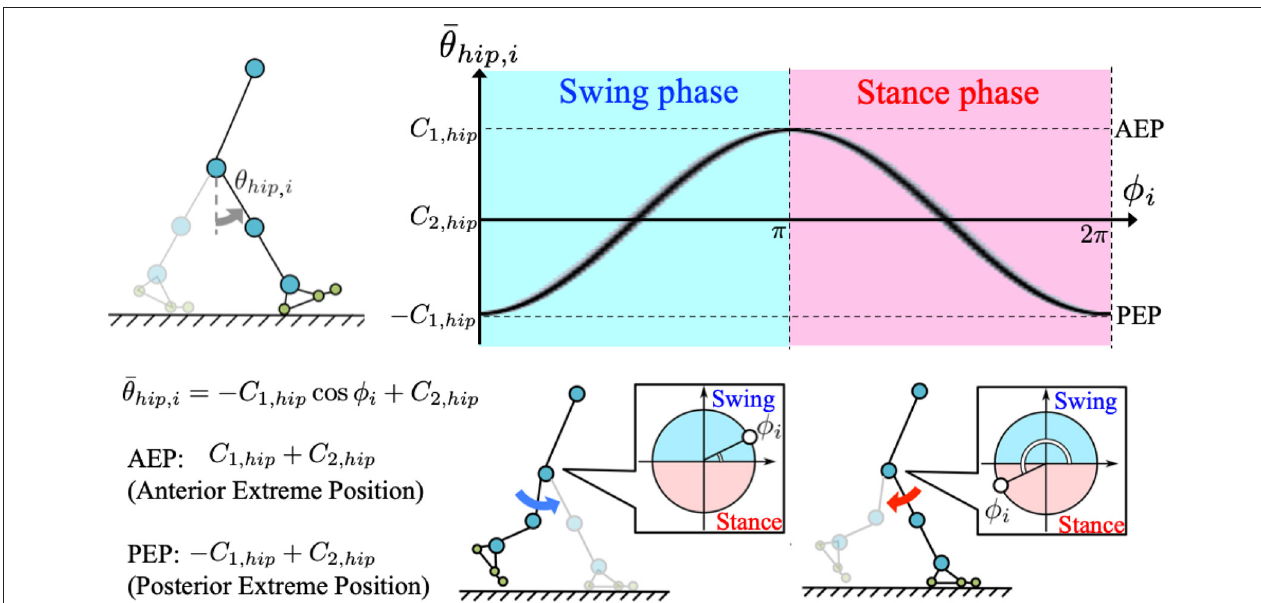
FIGURE 2 | Generation of target angle in hip joint control: we incorporated a phase oscillator as a component of the CPG-based model to generate target angle for the corresponding hip actuator. The target angle is described by ¯ θ hip , i = − C 1, hip cos φ i + C 2, hip , where C 1, hip , and C 2, hip are amplitude and offset angles of the hip target angle, respectively. According to the equation, posterior and anterior extreme positions (PEP and AEP, respectively) of the target angle result in − C 1, hip + C 2, hip ( φ i = 0,2 π ) and C 1, hip + C 2, hip ( φ i = π ), respectively. Therefore, legs are controlled to be in the swing phase for 0 ≤ φ i < π , and in the stance phase for π ≤ φ i < 2 π